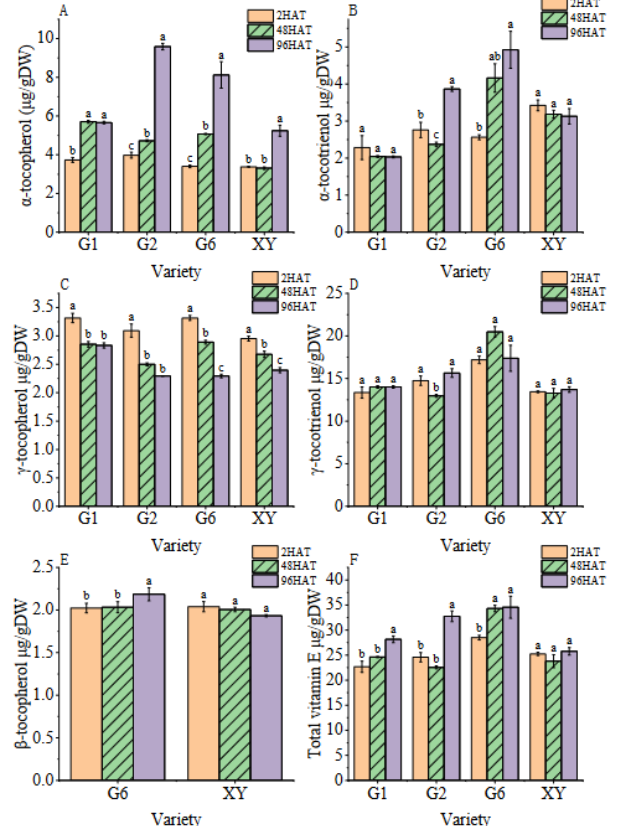
Figure 4. Bar chart of dynamic changes in vitamin E isomer content in brown rice during germination. ( A ): The α‐ tocopherol content. ( B ): The α‐ tocotrienol content. ( C ): The γ‐ tocopherol content. ( D ): The γ - tocotrienol content. ( E ): The β -tocopherol content. ( F ): The total vitamin E content. Treatments: 2 h after seed soaking treatment (2HAT), 48 h after seed soaking treatment (48HAT), 96 h after seed soaking treatment (96HAT). Varieties: Guanghei1 (G1), Guichao2 (G2), Guanghong6 (G6), Xiangyaxiangzhan (XY). Bars with different letters differ significantly at p < 0.05.